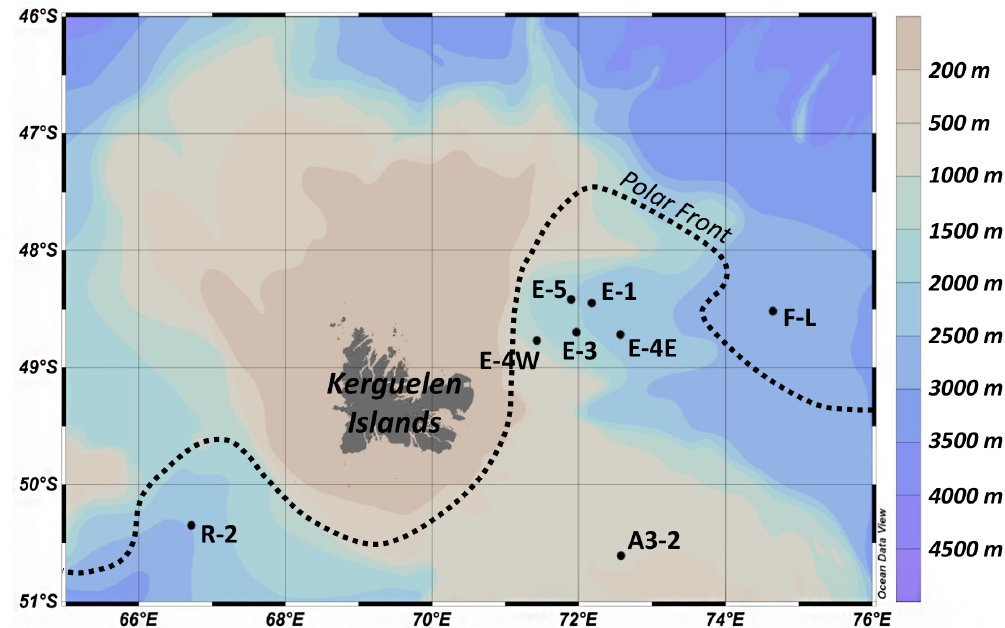
Figure 1. Map of the KEOPS-2 cruise area (Indian sector of the Southern Ocean) showing the location of stations discussed in this study. Dotted line represents the position of the polar front from Park et al. (2014). Table 1. Characteristics of the stations sampled for Si flux measurements during KEOPS-2. Ze represents the bottom of the euphotic zone (1% of surface photosynthetically active radiation), MLD is the mixed layer depth (from Park et al., 2014). Station